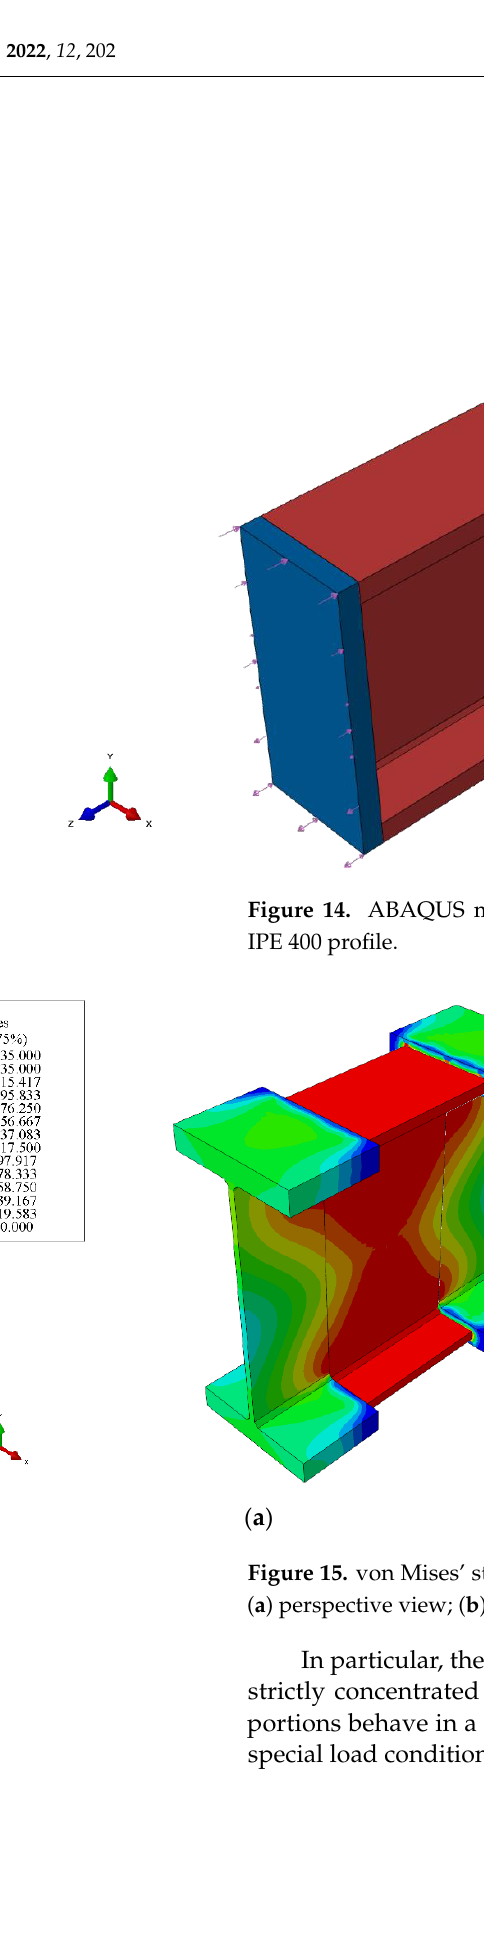
15 of 22 Figure 13. Dimensionless domains: HEA300 elastic (red line); HEA300 yield (black line); LRPD elas- tic (green line); LRPD yield (blue line). ( a ) design point 1; ( b ) design point 2. The next step consists of checking the mechanical behavior of the designed devices by means of a suitable FEM analysis performed in an ABAQUS environment. In Figure 14 the model for the LRPD designed for the IPE400 profile and design point 1 is sketched (models for the other LRPDs are similar). The model is constituted by four different parts, sketched in different colors in Figure 14. The central part (sketched in dark green) is the LRPD whose geometrical characteristics have been obtained by the optimal design. The first and third parts (sketched in dark white and dark red, respectively) are equal to each other and the related geometrical characteristics are equal to those of the outer parts of LRPD. The length of these parts is equal to that of the LRPD so that the overall length of the model, without the loading plate, is equal to 3ℓ . The last part (sketched in dark blue) is a plate where the loadings are applied with a thickness of 𝑡 = 30 mm . Each part has been tied to the next one to ensure a perfect kinematic compatibility. The overall model is that of a cantilever beam so that the white part is clamped at its end section while the dark blue part is free. The adopted mechanical behavior for the material is an elastic-perfectly plastic one with Young’s modulus equal to 210 GPa, yield stress equal to 235 MPa, ulti- mate strain equal to 25% and adopted mesh is 5 mm with hexahedral standard 3D stress elements. The loading plate is constituted by linear elastic material with a stiffness that is much greater than the one of the adopted steel (210 TPa), so that any influence of the pressure distribution is avoided. Two different pressure loads (pink arrows in Figure 14)